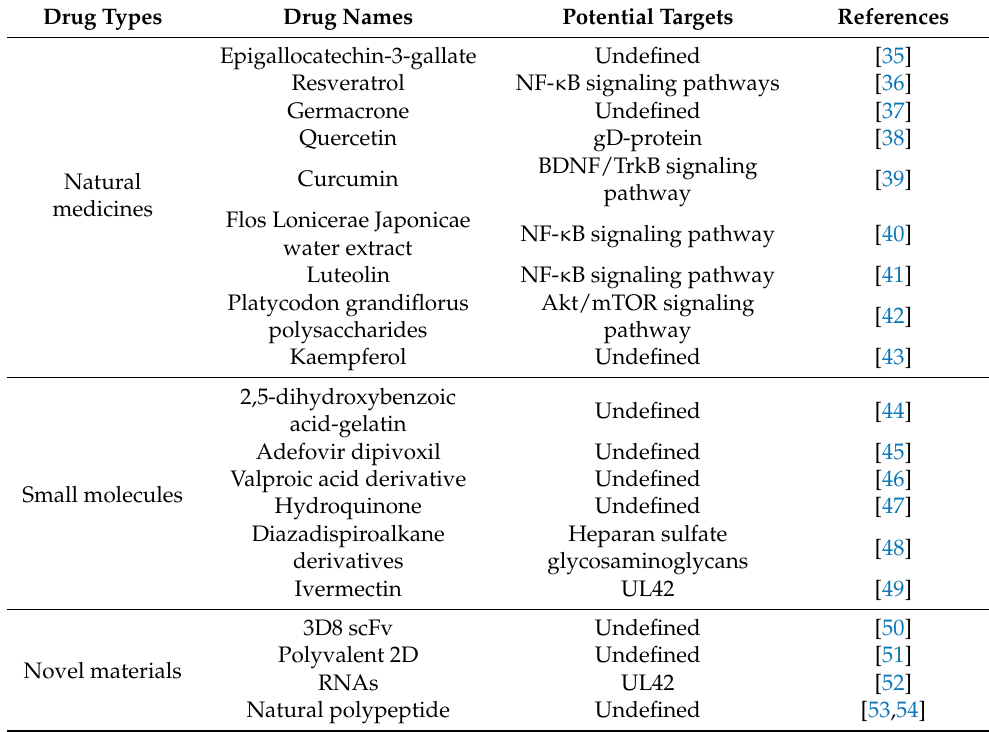
Table 1. The reported anti-PRV